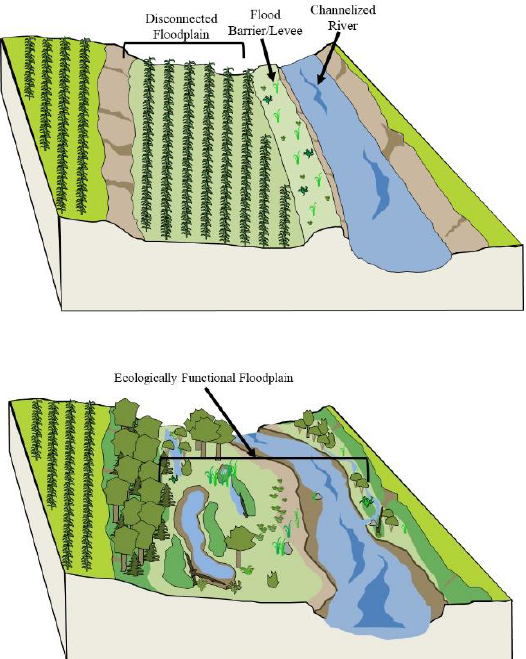
Figure 1. This is a depiction of a disconnected and non-functional versus an ecologically functional floodplain. Ecologically functional floodplains flood regularly without constructed barriers or incised main channels that prevent water from entering the floodplain during high-flow events. They are also capable of supporting plant and animal communities native to that region.